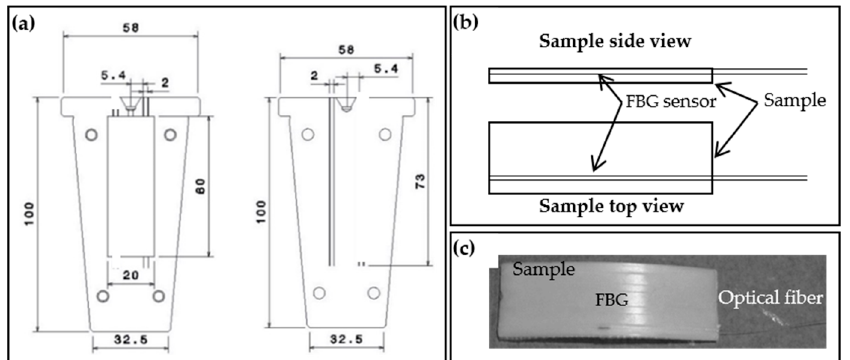
Figure 2. ( a ) Schematic representation of the designed mold tool (dimensions in millimeters); ( b ) Schematic representation of an injected sample with the embedded fiber Bragg grating (FBG) sensor; ( c ) Photograph of a shape memory polyurethane (SMPU) with the embedded FBG.